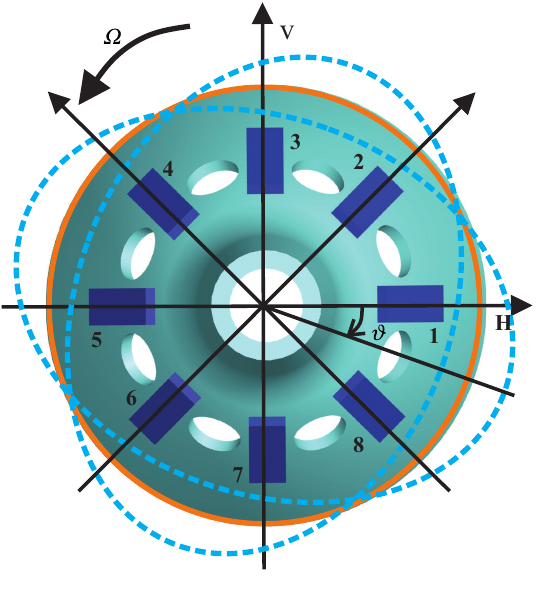
Figure 6. Schematic of the standing wave